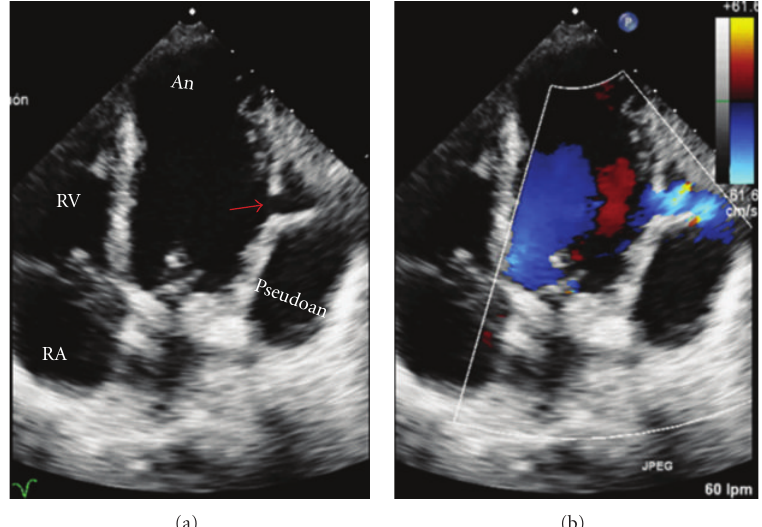
Figure 6: Two-dimensional (a), and color Doppler four-chamber view (b) images showing an apical aneurysm (LVAn) and lateral pseudo- aneurysm formation (red arrow) with shunt from the left ventricle to the pericardial space. RV-right ventricle, RA-right atrium, Pseudoan- pseudoaneurysm.